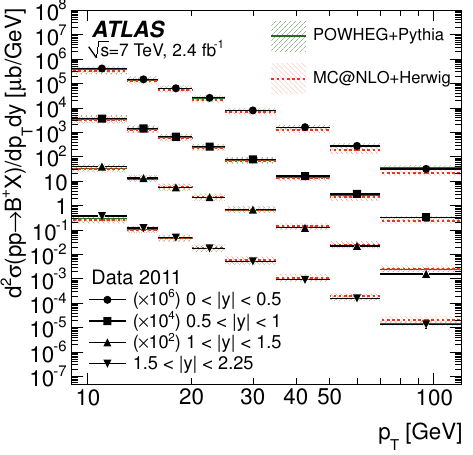
Figure 1. Double-di ff erential cross-section of B + production as a function of p T and y , averaged over each ( p T ,y ) interval and quoted at its centre [3]. The data points are compared to NLO predictions from P owheg and MC@NLO. The shaded areas around the theoretical predictions reflect the uncertainty from renormalisation and factorisation scales and the b -quark